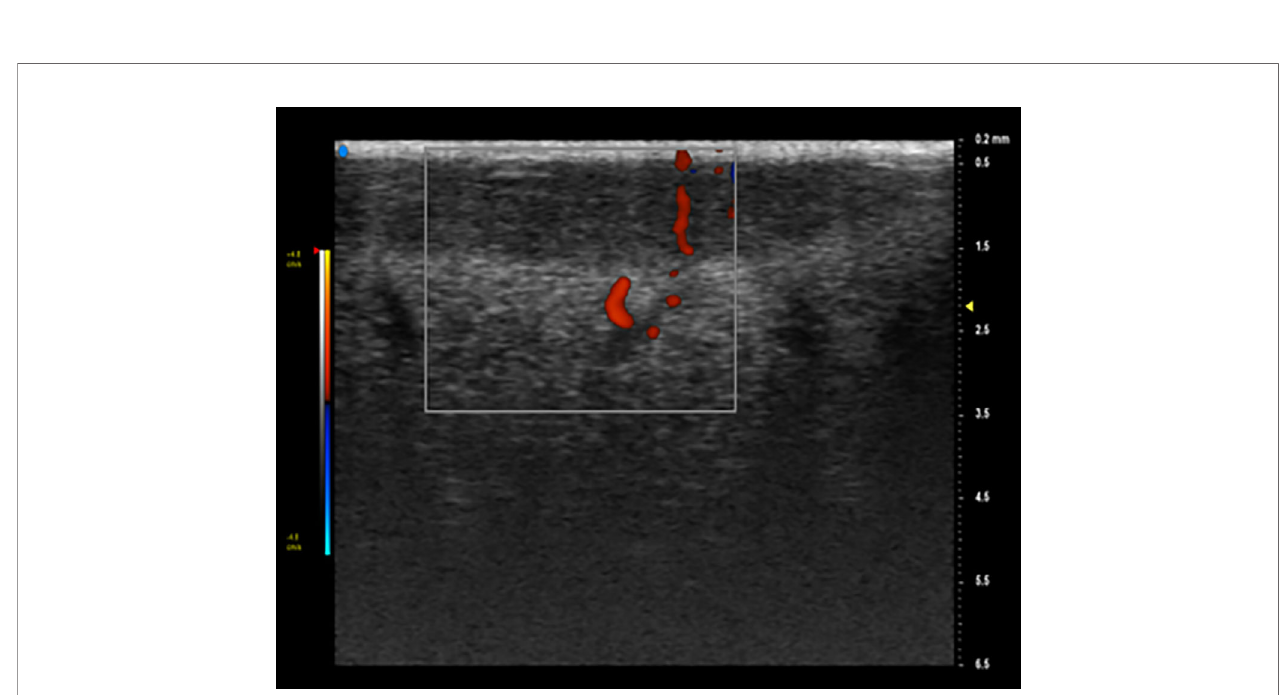
FIGURE 3 | Doppler is an additional tool that can identify intra-tumor vessels and characterize their distribution, improving diagnostic accuracy. On Color Doppler examination, it is possible to see a hypoechoic lesion with an increased vascular